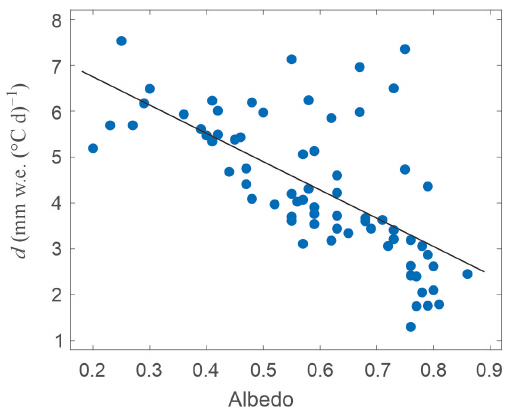
Figure 9. Degree-day melt factor, f , as a function of monthly mean albedo and melt energy at the Haig Glacier AWS site for MJJAS from 2002 to